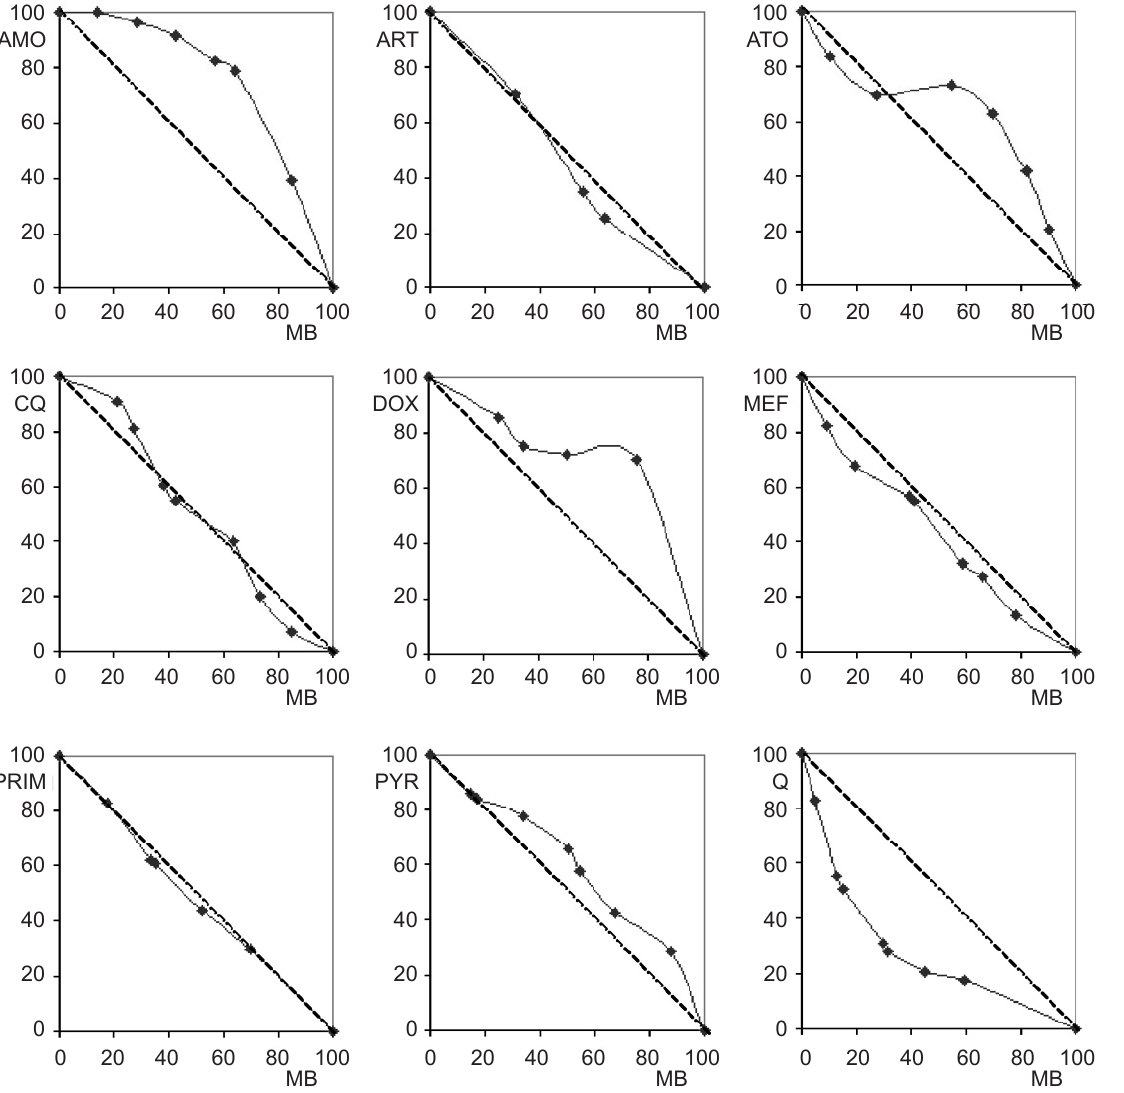
The straight line in each panel represents additivity. Points located below this line indicate synergism, data points above the line indicate antagonism. AMO = amodiaquine; ART = artemether; ATO = atovaquone; CQ = chloroquine; DOX = doxycycline; MEF = mefloquine; MB = methylene blue; PRIM = primaquine; PYR = pyrimethamine; Q = quinine. Fig. 2. – Isobolograms of drug interactions between MB and other antimalarial